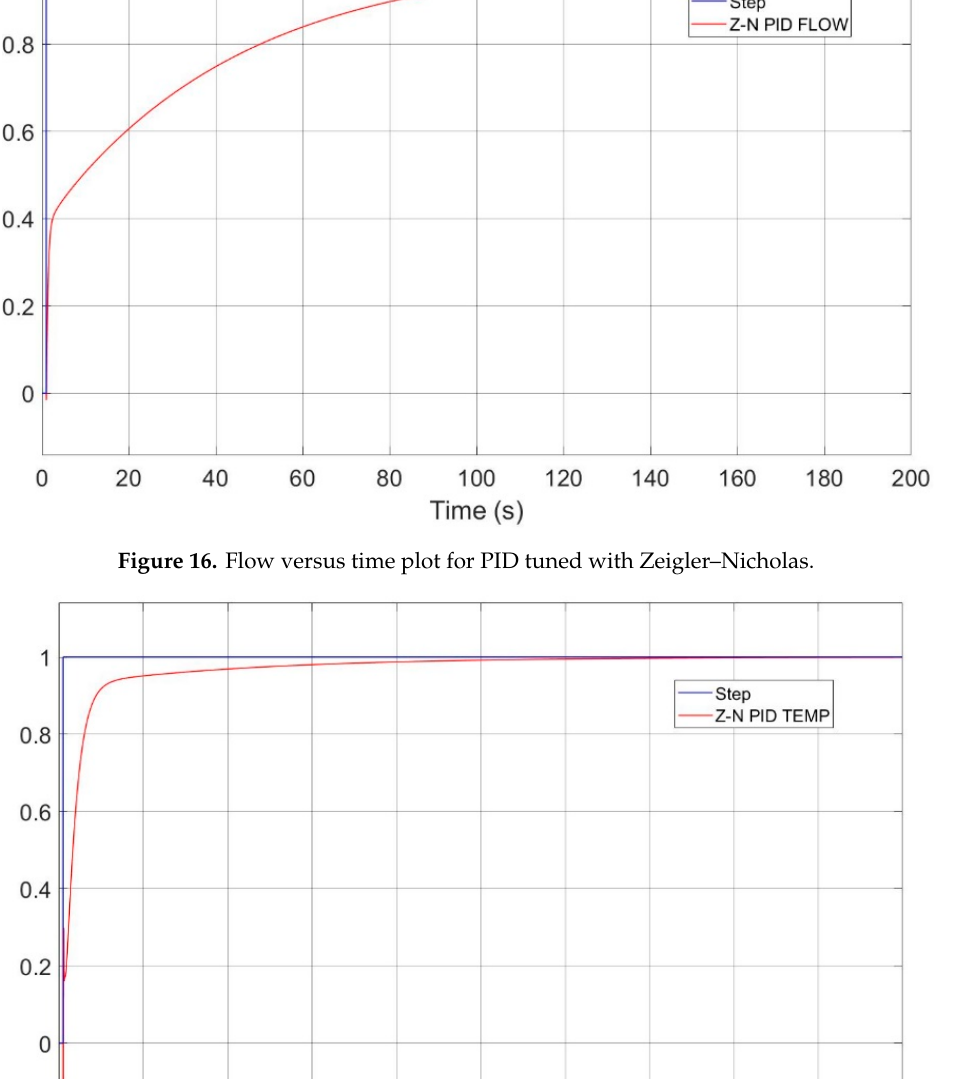
Figure 15. Simulink simulation of flow and temperature system (fuzzy PID).